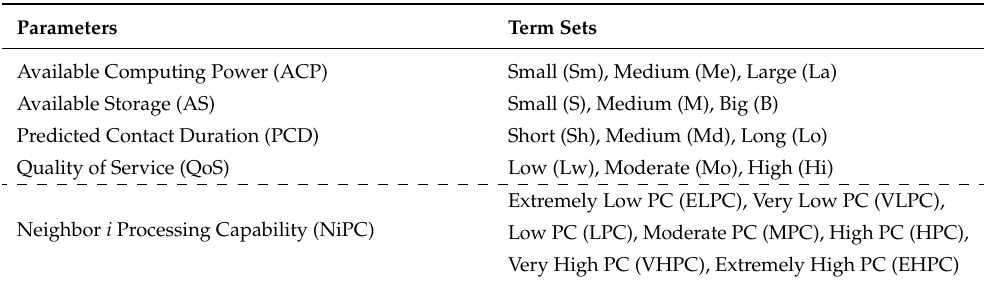
Table 2. Parameters and term sets for